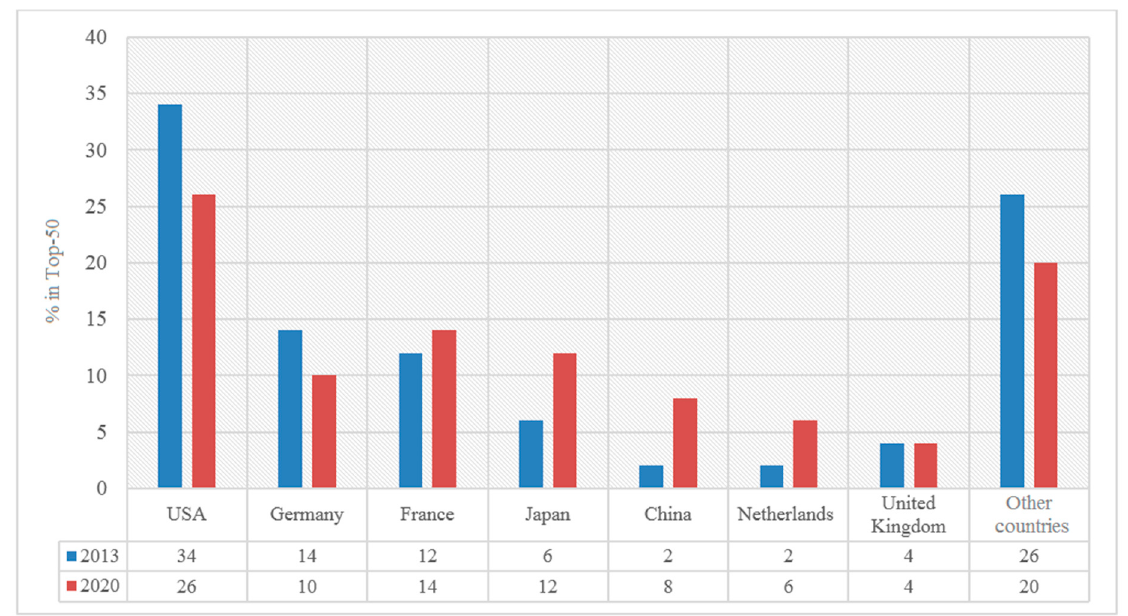
Figure 6. Change of structure of Top 50 Global Retailers (based on data from NRF: https://nrf.com/blog/2020-top-50-global- retailers).